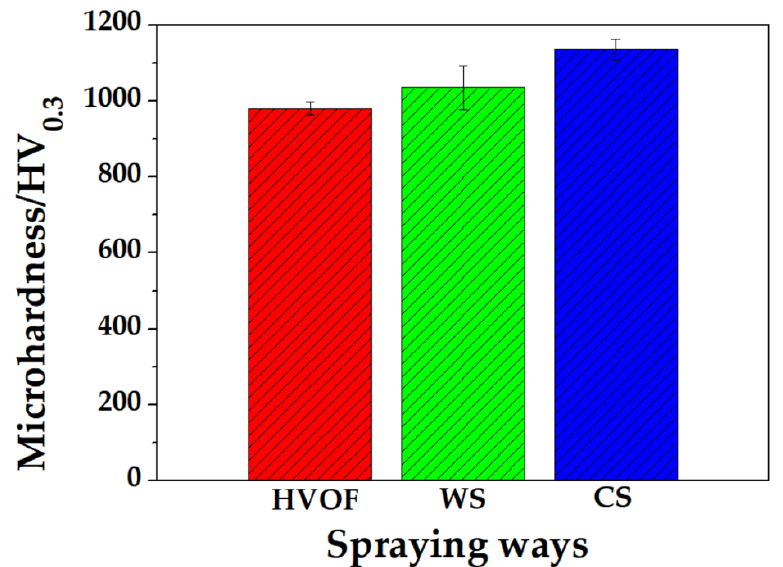
Figure 15. Microhardness of WC-17Co coatings formed by various spraying methods.